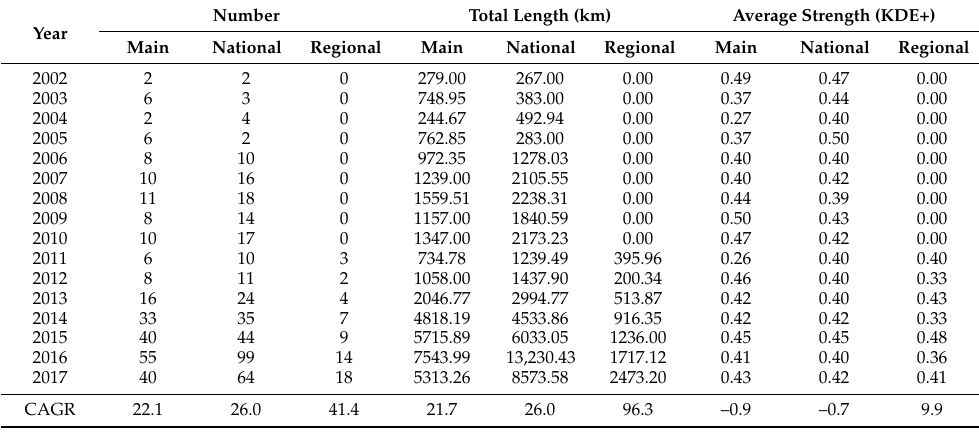
Table A3. The number, length, and strength of ungulate–vehicle collision (UVC) hotspots on different categories of